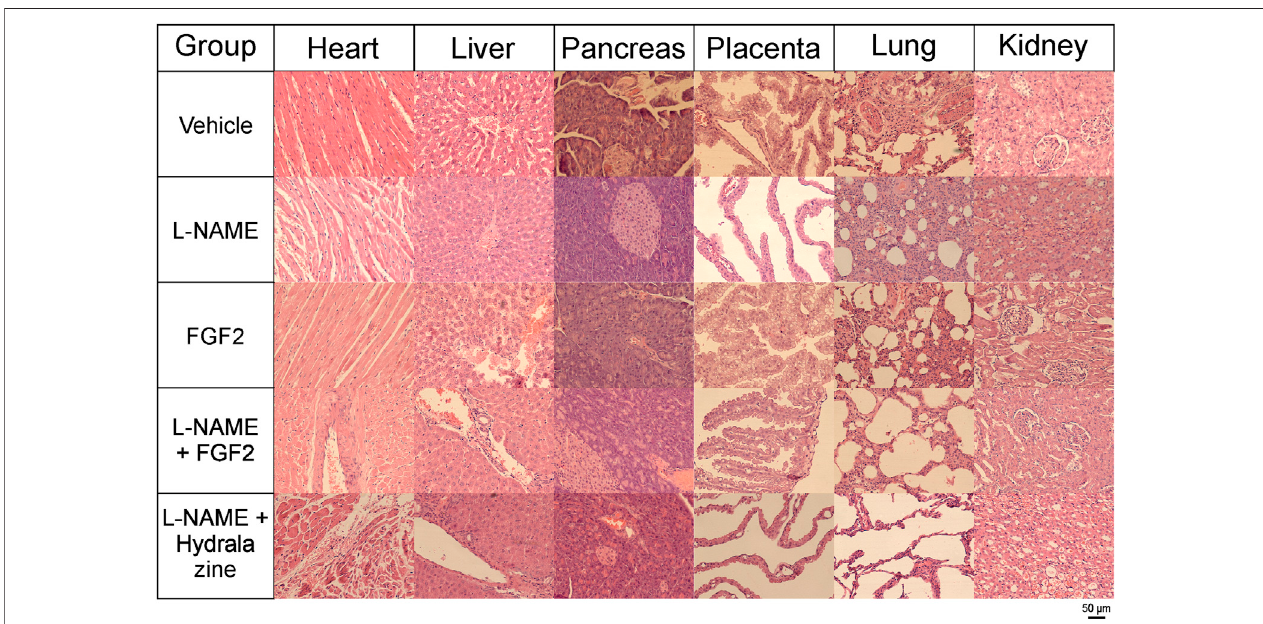
FIGURE 6 | Histology of tissues from rhFGF2-treated animals (H&E staining). Tissue sections from heart, liver, pancreas, placenta, lung and kidney from all experimental groups stained with H&Eand visualized with an Axiocam 503 color camera, attached to an Axio Observer Z1 motorized inverted fl uorescence microscope with a LD Plan-NEOFLUAR 20x/0.4 Ph2 Korr